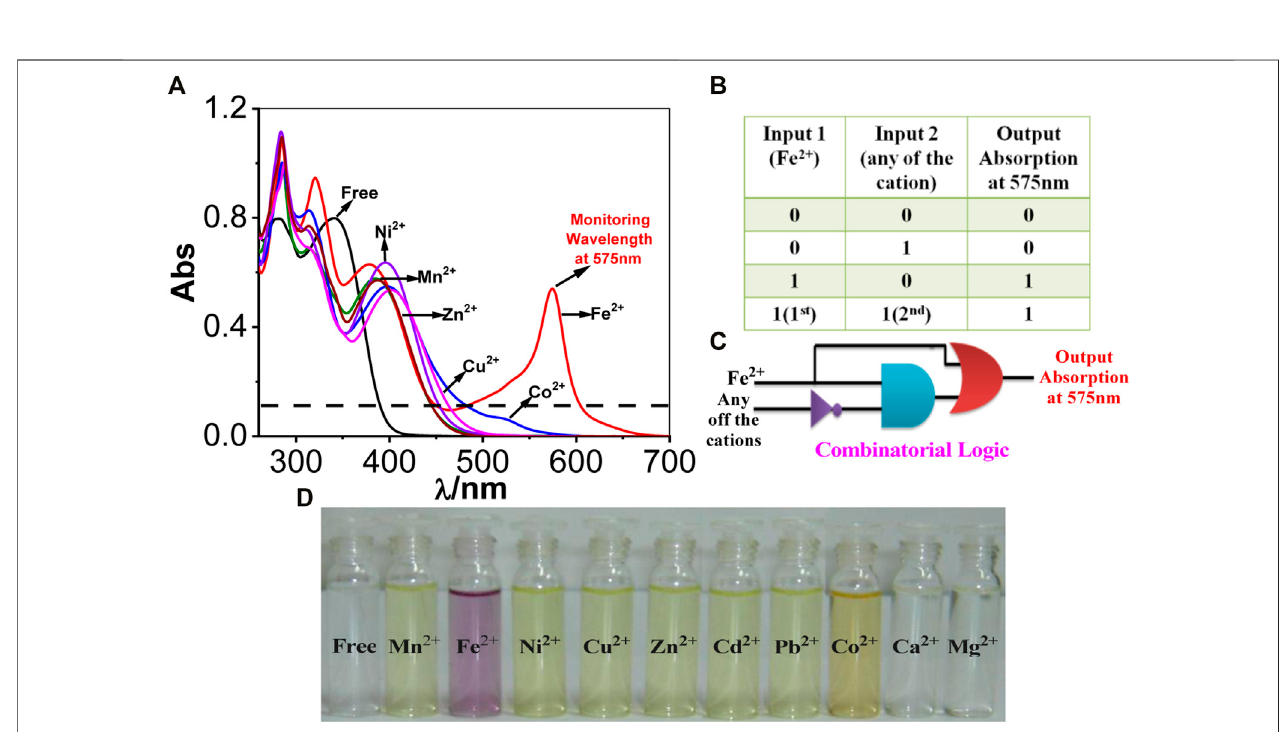
FIGURE 1 | (A) UV-Vis absorption spectrum of tpy-HImzPh 3 in the presence of different cations. (B) Truth table of the combinatorial logic system. (C) Schematic diagram of the combinatorial logic system. (D) Visual color changes in the presence of various cations.